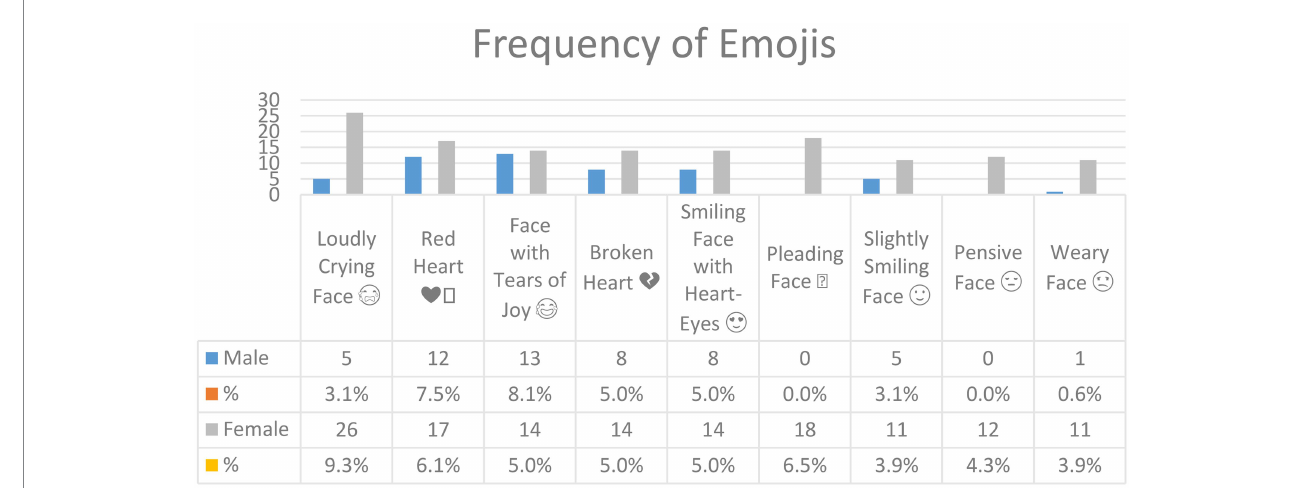
FIGURE 1 The most common emojis in Arabic tweets.